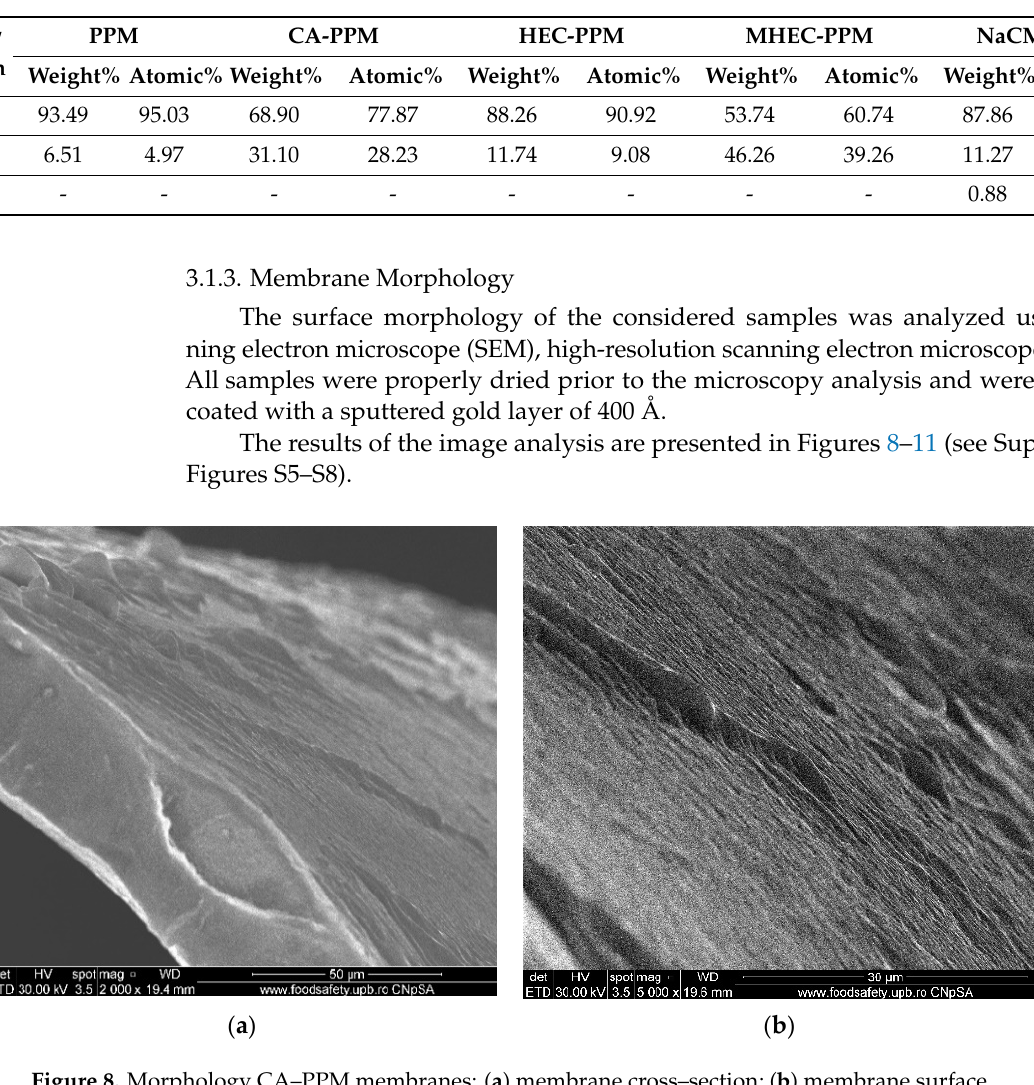
( a ) ( b ) Figure 10. Morphology MHEC–PPM membrane: ( a ) membrane cross–section; ( b ) membrane surface. ( a ) ( b ) Figure 11. Morphology NaCMC–PPM membranes: ( a ) view; ( b ) membrane surface.